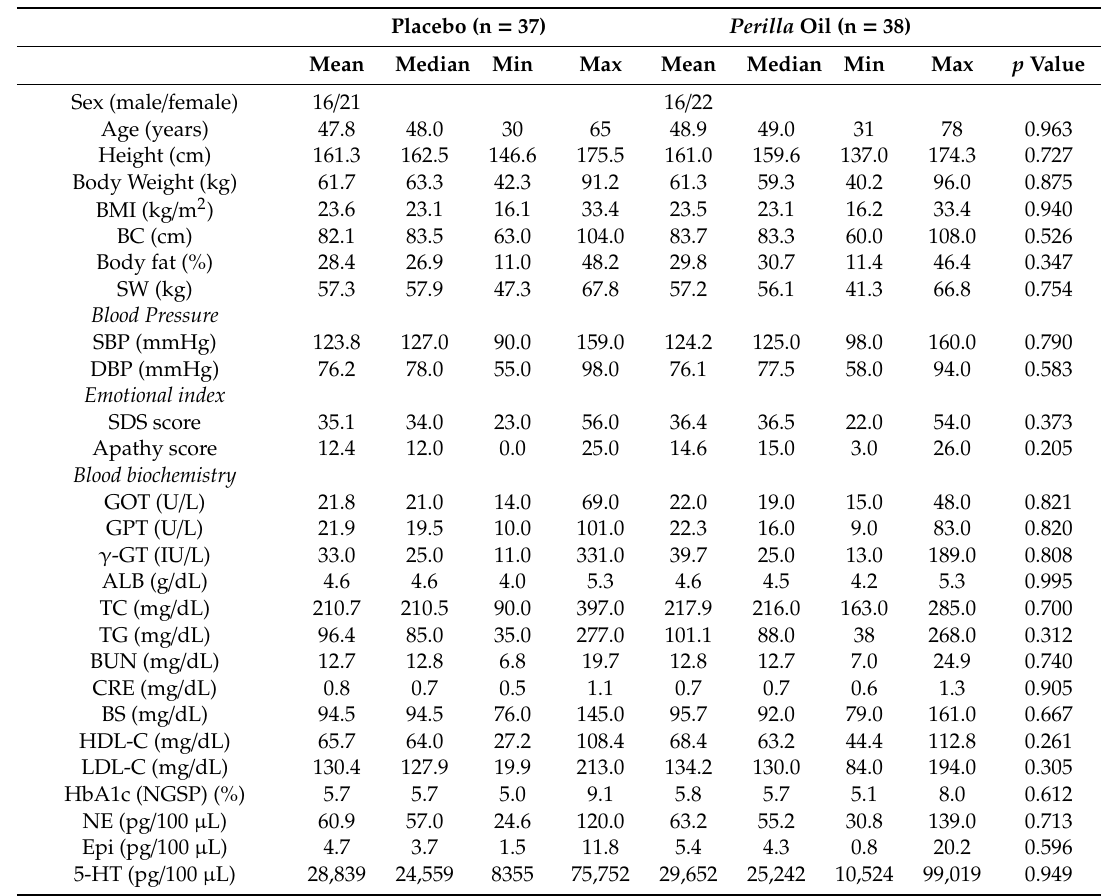
Table 2. Participant’s base line parameters.